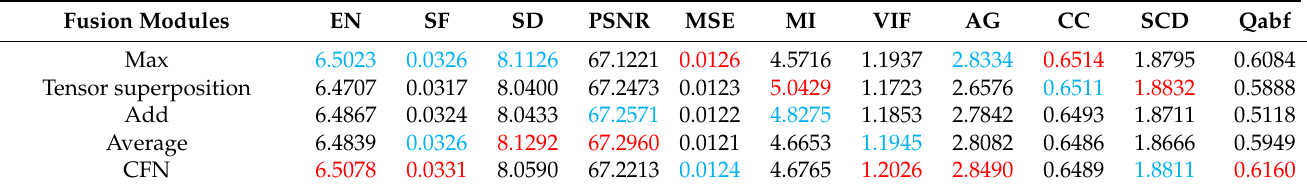
Table 3. The following are the fusion results of different fusion modules. Red marks are optimal and blue marks are suboptimal.